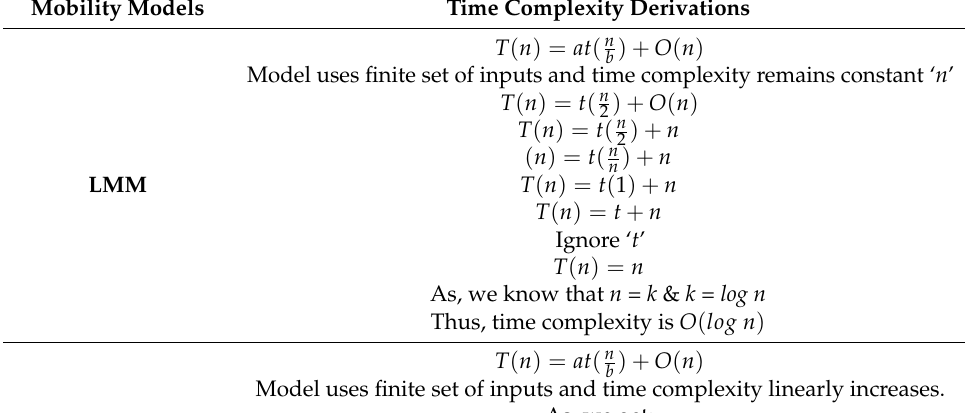
Table 3. Time complexity for SDAAA and contending